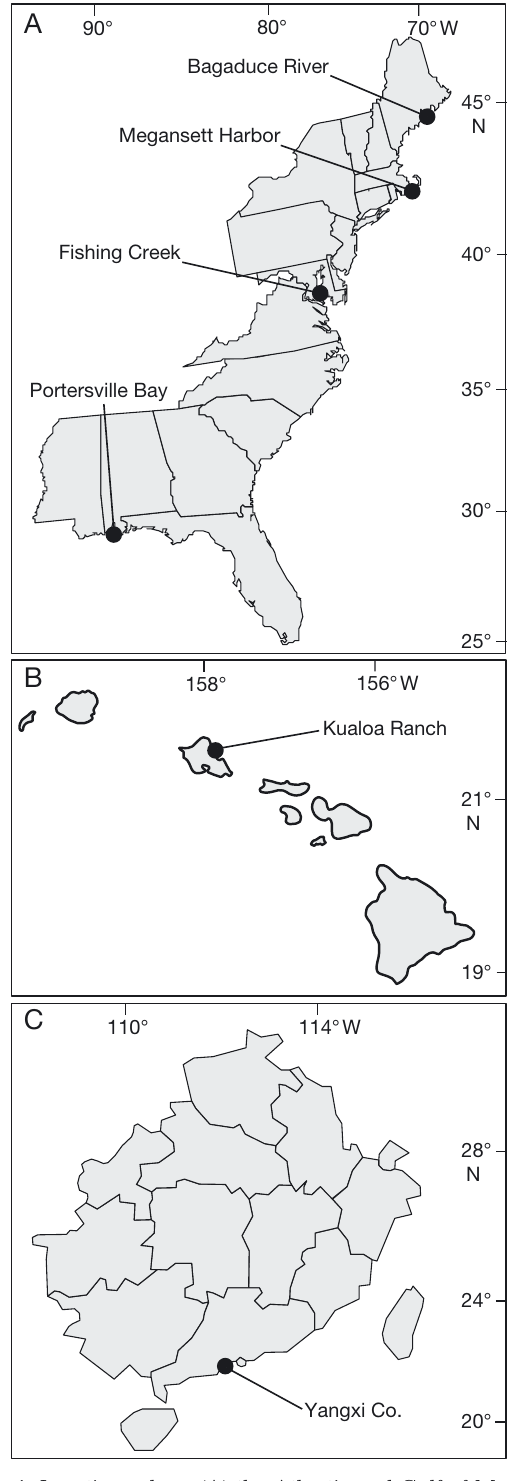
Fig. 1. Locations along (A) the Atlantic and Gulf of Mexico coasts of the USA and (B) on Hawaii, where Polydora web- steri was sampled in this study. (C) Location in Yangxi County, Guangdong Province, China, where Ye et al. (2017) obtained their samples of P.